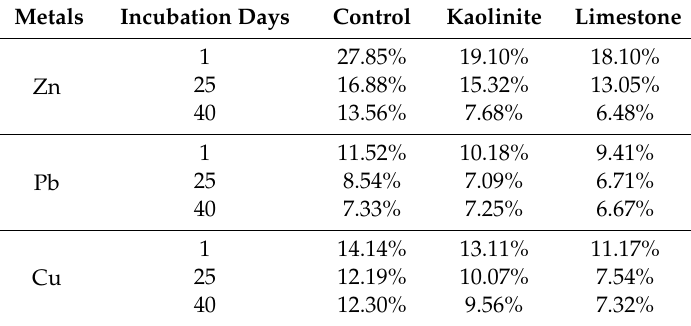
Table 5. The mobility factor (MF%) value of three metals with di ff erent